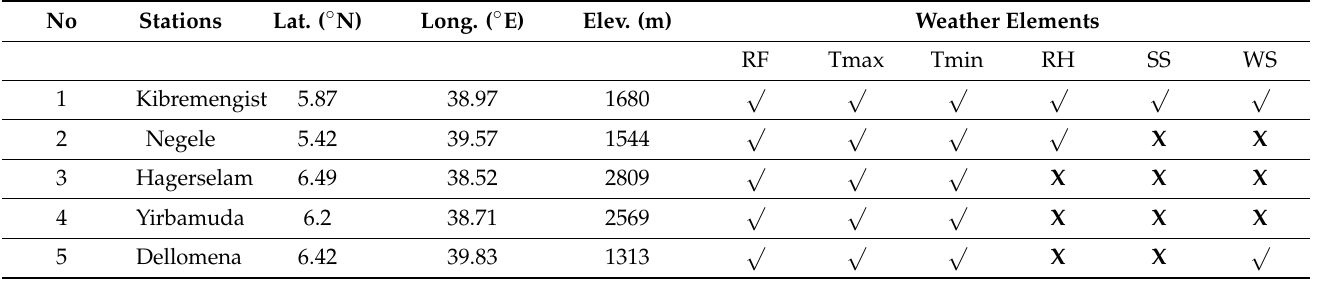
Table 2. Meteorological stations for the Genale Dawa-3 dam watershed